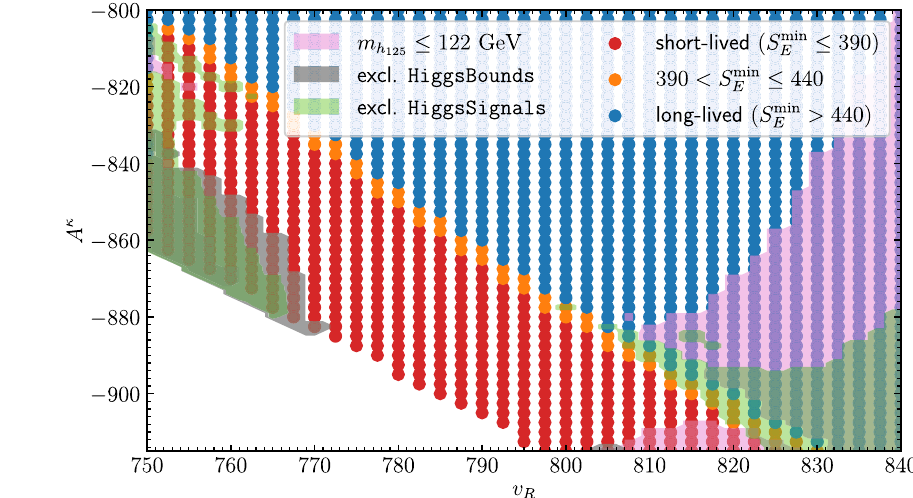
Fig. 4 Vacuum stability constraints in the v R - A κ plane. Blue points feature a sufficiently long-lived EW vacuum, while the red points give rise to a rapidly decaying EW vacuum. The orange points feature a potentially short-lived EW vacuum (see text). The gray and green areas indicate excluded regions based on the HiggsBounds and HiggsSignals constraints (see text for details), and the pink area indicates the parameter region in which < 122 m h 125